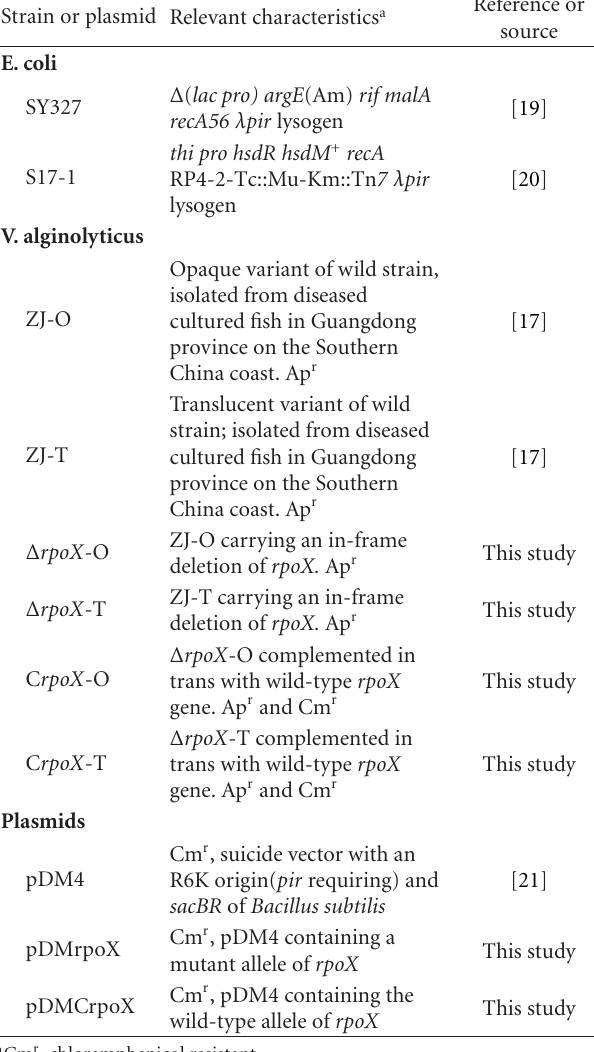
Table 1: Bacterial strains and plasmids used in this study. Strain or plasmid Relevant characteristics